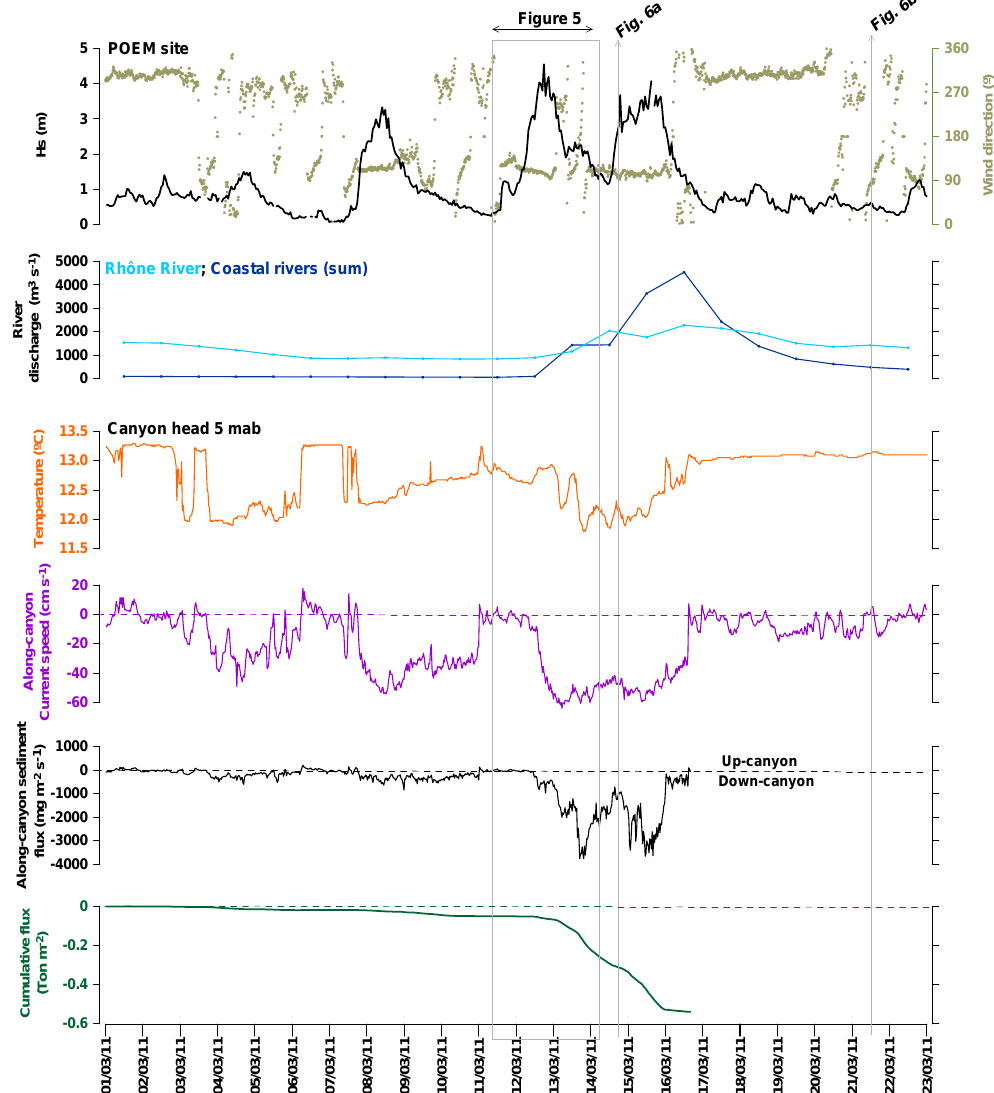
Fig. 4. Meteorological, hydrological and hydrodynamic context in the study area during the CASCADE cruise. From top to bottom: wind direction and significant wave height measured at the POEM coastal site; mean daily water discharge of the Rh ˆ one River and the sum of coastal rivers opening to the Gulf of Lion; near-bottom water temperature, along-canyon (130 ◦ rotated) current speed, sediment flux and cumulative sediment transport (positive values are offshore; negative onshore) at the canyon head. The dotted square marks the dates of a 3-day fixed CTD station (see the text and Figs. 5, 6). Vertical dotted lines correspond to two across-canyon CTD transects conducted before and after the main stormy